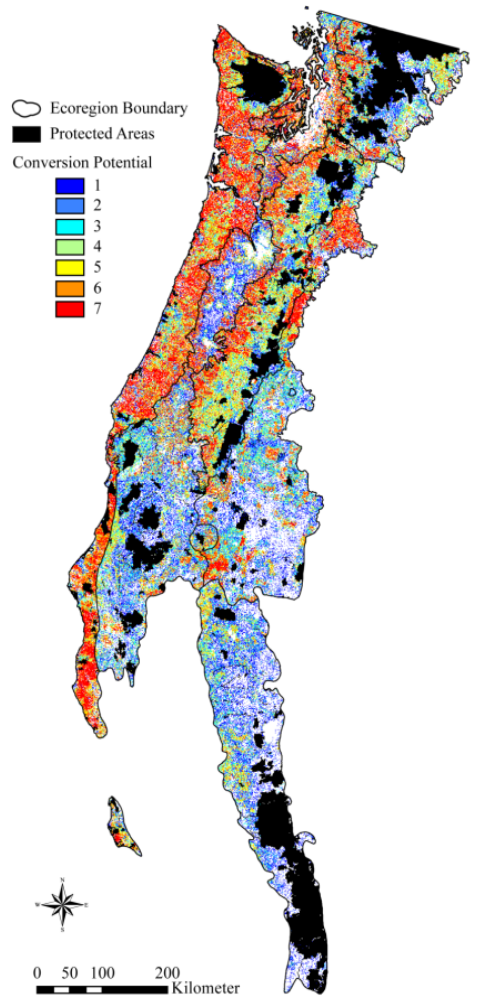
Figure 6. Conversion potential into developed, agriculture and forest harvest lands in the Pacific Northwest from 2000 to 2100. Values 1–7 represent the number of scenarios projecting land-use conversion over the modeled period. Ecoregion boundaries are shown and protected areas are indicated in black.